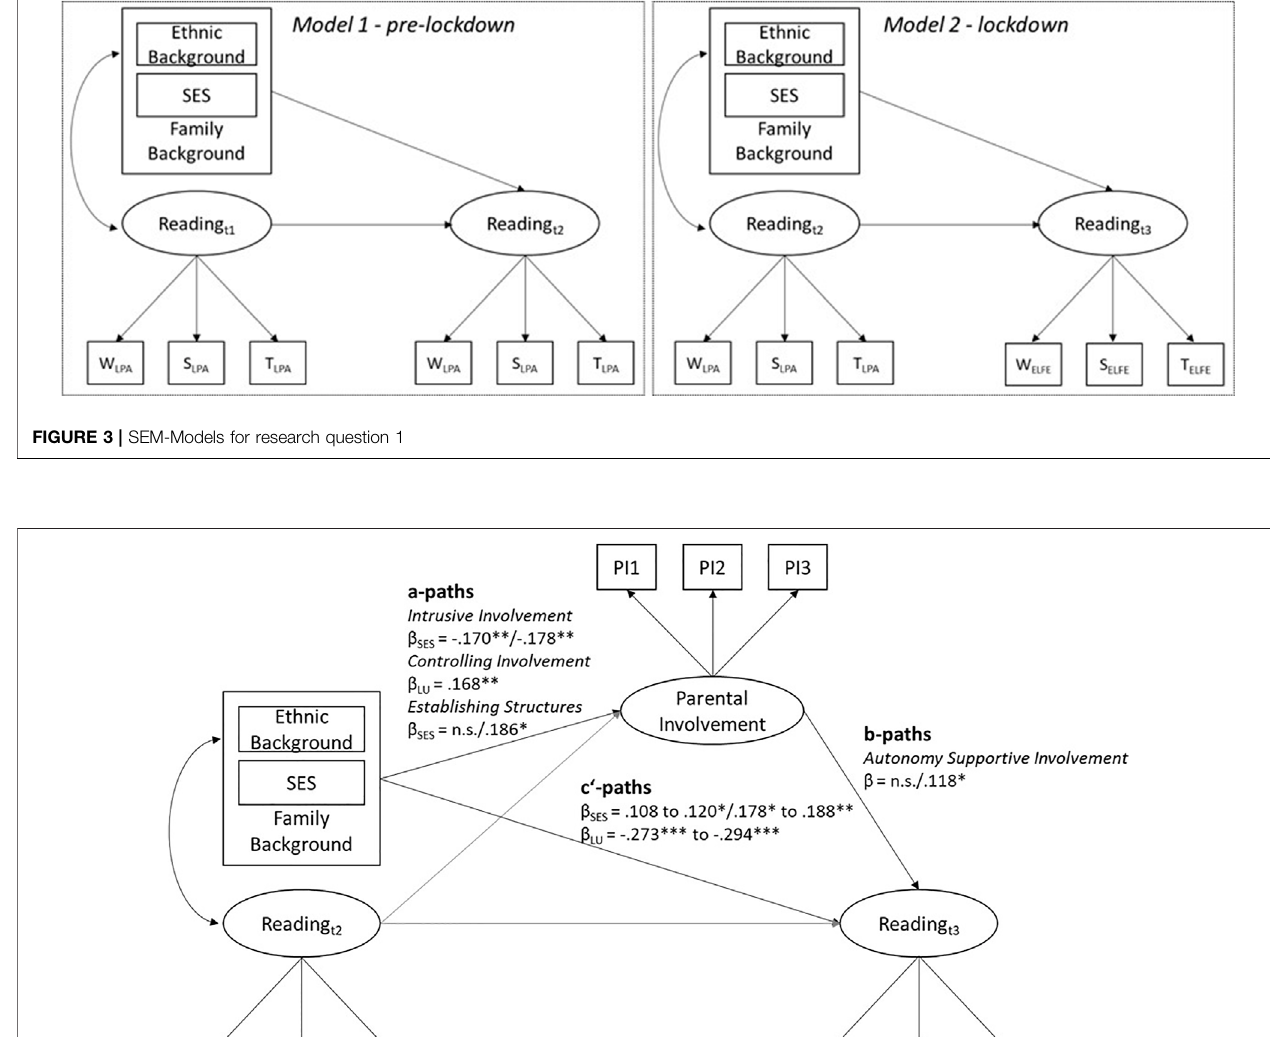
Frontiers in Education |